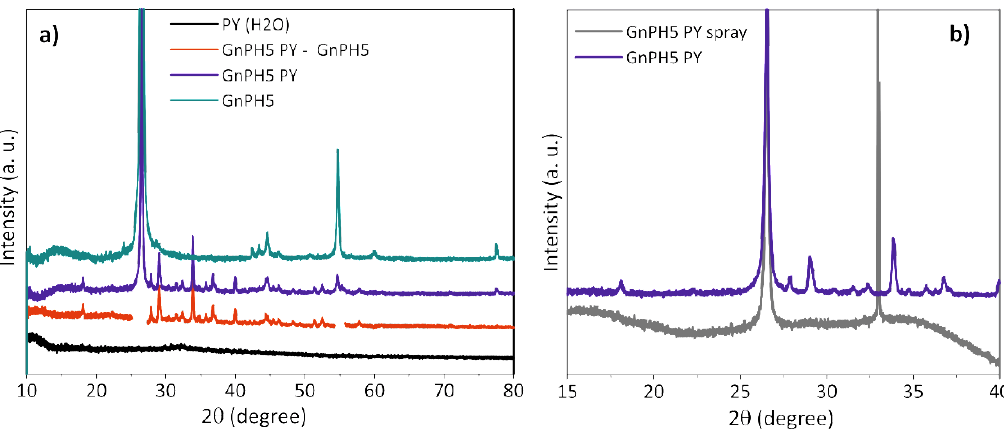
Figure 8. X-Ray intensity profiles of GnPH5 and PY, as well as the exfoliated GnPH5 PY ( a ), as a powder formed by solvent evaporation from the bulk suspension or by spray deposition on a Si wafer ( b ).